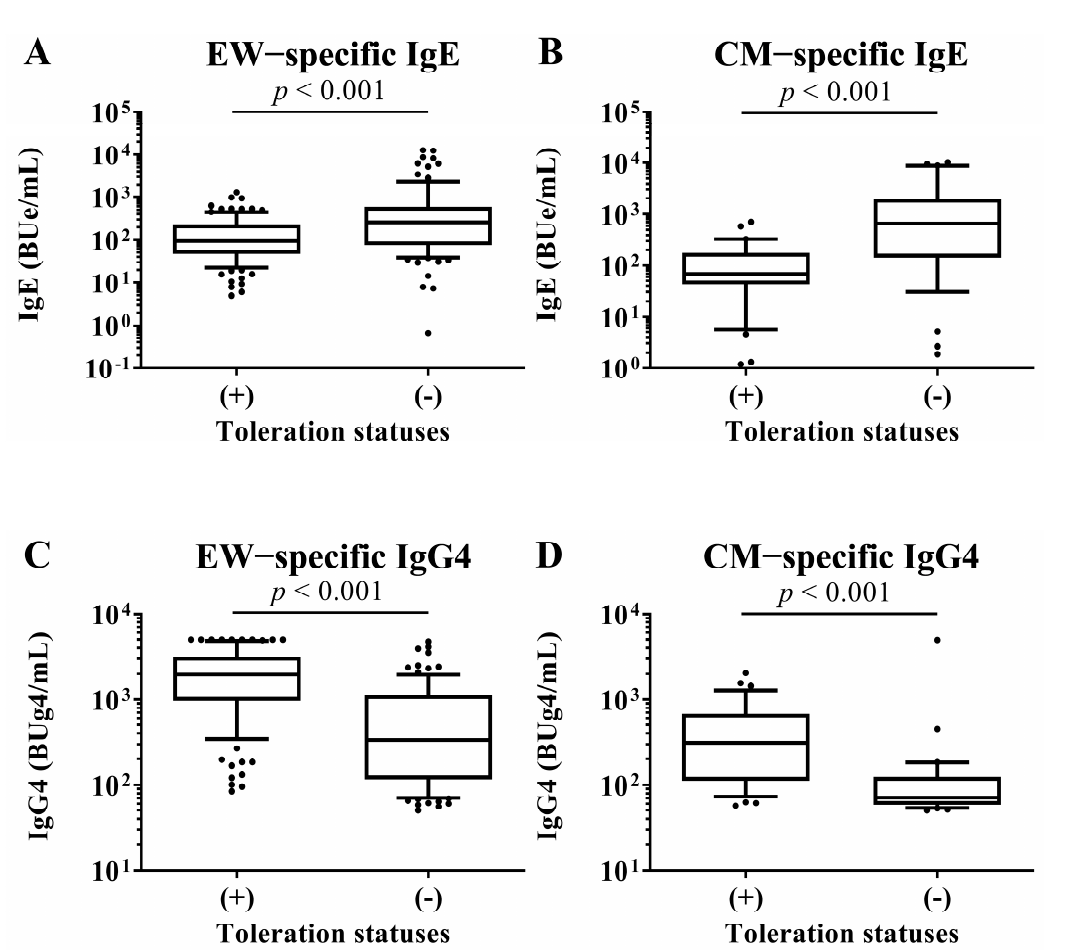
Figure 4. Comparison of EW-specific IgE and IgG4 levels in sera of children at 2 years old between children with tolerance to HE and children without tolerance to HE. Comparison of CM-specific IgE and IgG4 levels in sera of children at 2 years old between children with tolerance to CM and children without tolerance to CM. These show results in ( A ) EW-specific IgE level, ( B ) CM-specific IgE level, ( C ) EW-specific IgG4 level and ( D ) CM-specific IgE level. p -values were calculated for each log-converted Ig level using Mann–Whitney U test. p -values < 0.05 were considered